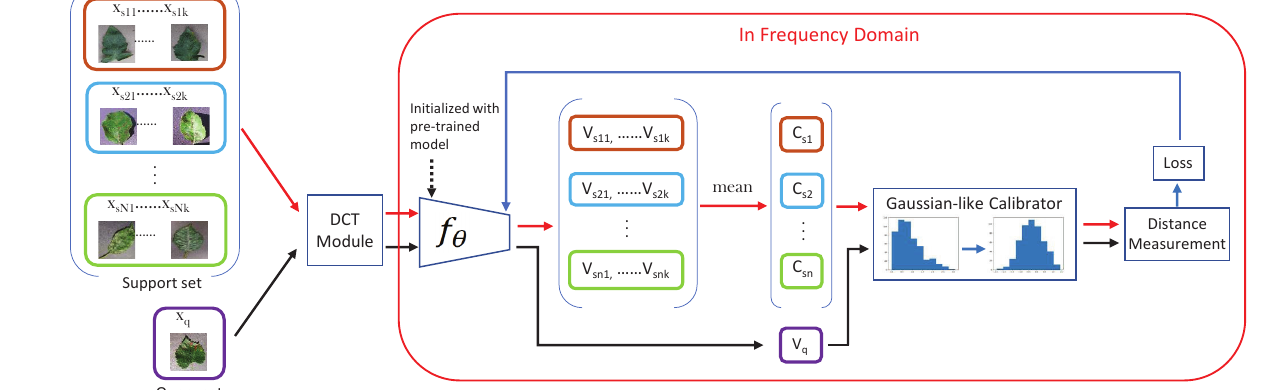
Figure 7. The network’s